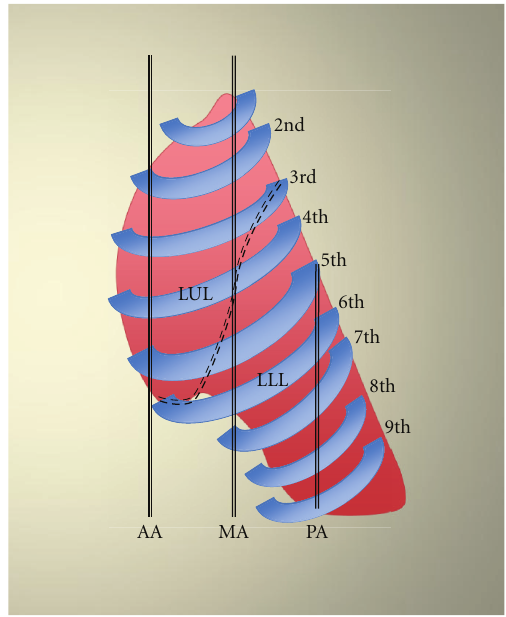
Figure 3: Lateral view of the left lung. Schematic representation of pulmonary lobes in relation to ribs and intercostal spaces along anterior axillary (AA), midaxillary (MD), and posterior axillary (PA) lines,